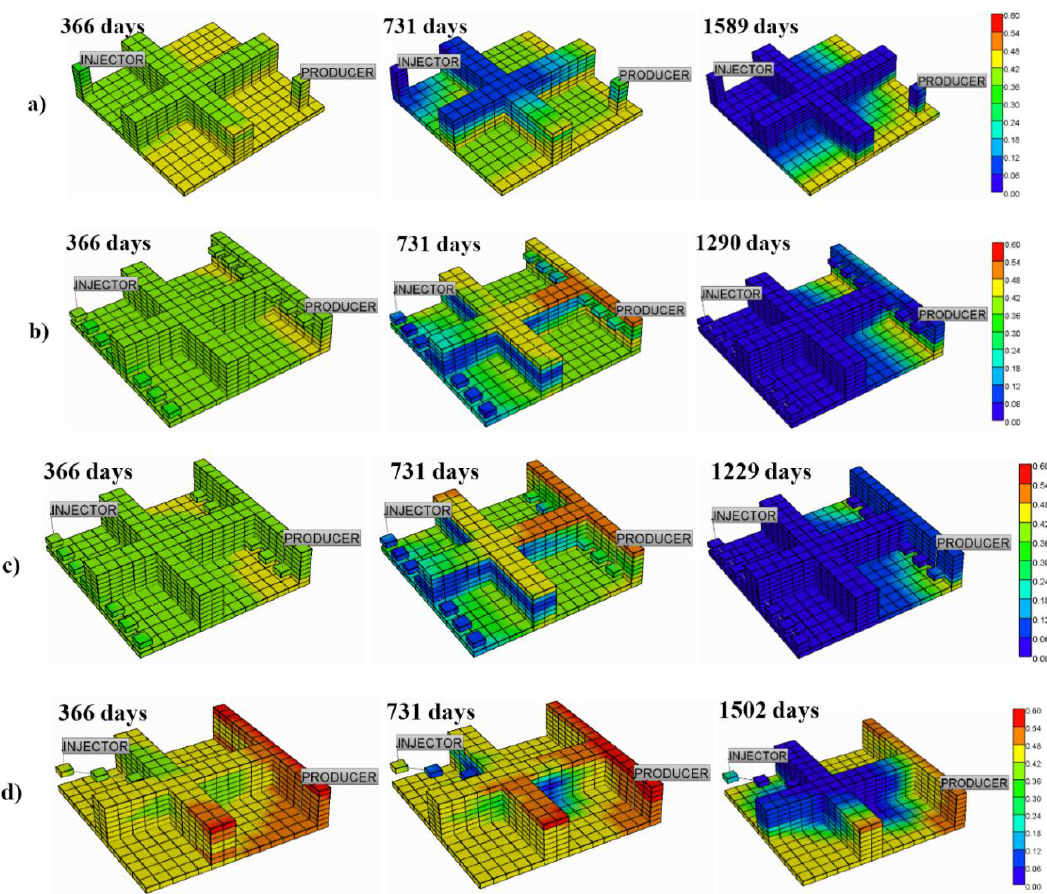
Figure 6. Oil saturation profiles of various well combinations during the EOR processes until the end of the project: ( a ) V-V; ( b ) H 3-H 1; ( c ) H 3-H 3; ( d ) H 45-2-H 45-4.